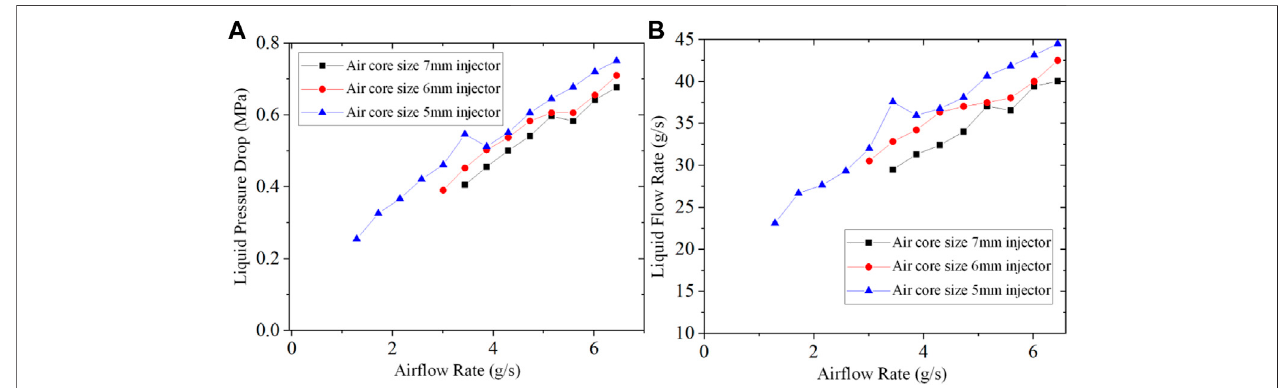
FIGURE 14 | Impacts of the gaseous core size on the (A) liquid pressure drop and (B) liquid fl ow rate under the different gaseous fl ow rates.